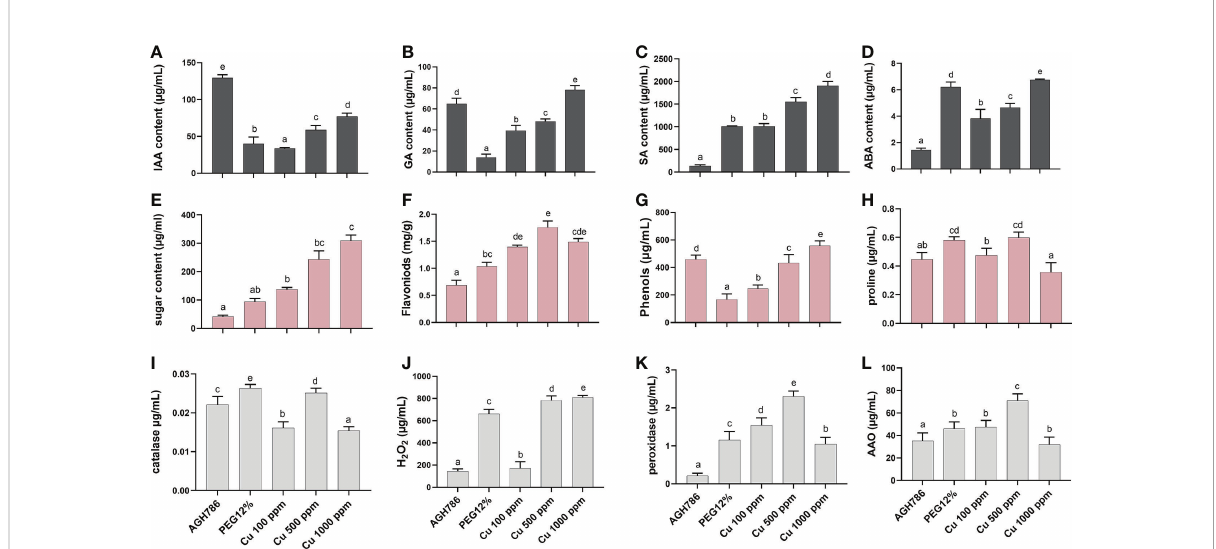
FIGURE 2 Effect of P. spadiceum AGH786 on hormonal content of S. lycopersicum L. under heavy metal (Cu) toxicity and drought stress (12% PEG). (A) Indole-3-acetic acid (IAA) level, (B) gibberellic acid (GA) level, (C) salicylic acid (SA) level, (D) abscisic acid (ABA) level, (E) total soluble sugars, (F) total fl avonoids, (G) total phenolics, (H) proline content, (I) catalase activity, (J) H 2 O 2 content, (K) peroxidase activity, and (L) ascorbate oxidase activity under different concentrations of Cu and 12% PEG in liquid media. Data represent the mean with standard error, and letters represent the signi fi cant difference (p <